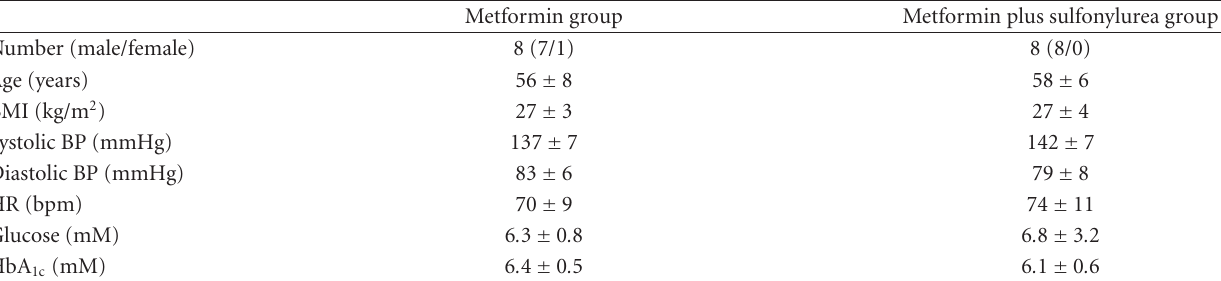
Table 2: Diabetic patients, baseline